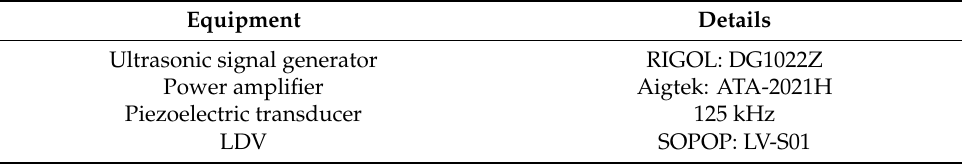
Figure 2. ( a ) The UGW scanning experimental system for lithium-ion batteries; ( b ) LDV is used to scan the lithium-ion battery, and the ultrasonic signals at each scanning point are obtained. Table 3. Experimental equipment information.